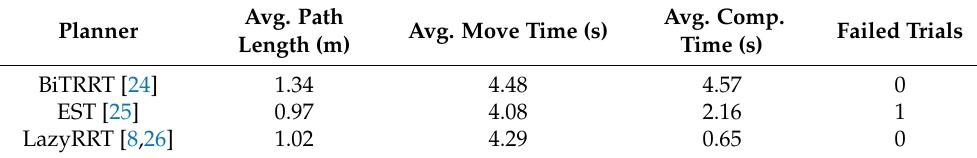
Table 1. Simple grasping target.